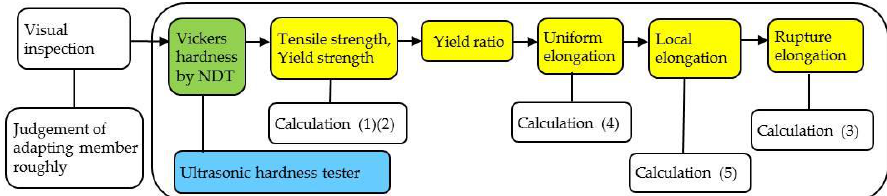
Figure 2. Estimation flow of mechanical properties.